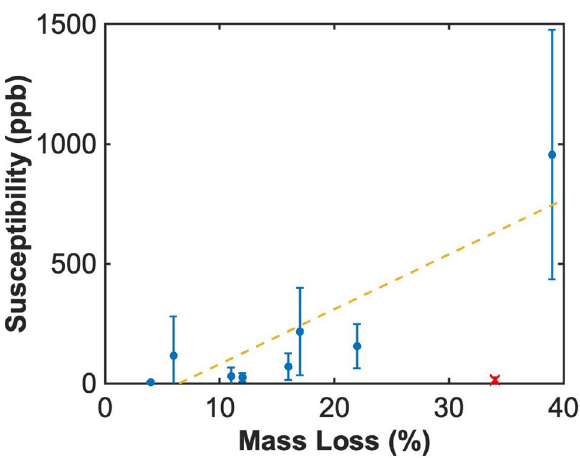
Figure 7. Comparison of sample thrombolytic susceptibility (mass loss) and magnetic susceptibility (QSM analysis). Error bars represent the range of positive QSM values observed within the sample. Separate segments of each specimen were subjected to the clot mass loss assay and imaging analysis. One sample was highly heterogenous (red cross), and gross observation indicated strong variation between the portion of that specimen that was subjected to rt-PA and the portion subjected to QSM analysis. The dashed yellow line is a least-squares best fit to the data. A significant correlation was observed between the thrombolytic and magnetic susceptibility of the sample (Spearman’s rho = 0.90, p < 0.01, N = 8 samples) The heterogenous sample (red cross) was excluded from